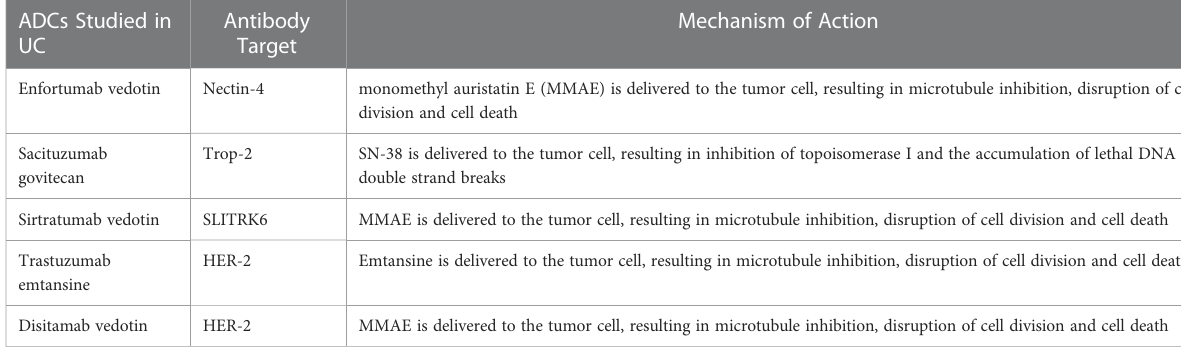
TABLE 1 Currently approved ADCs in the management of